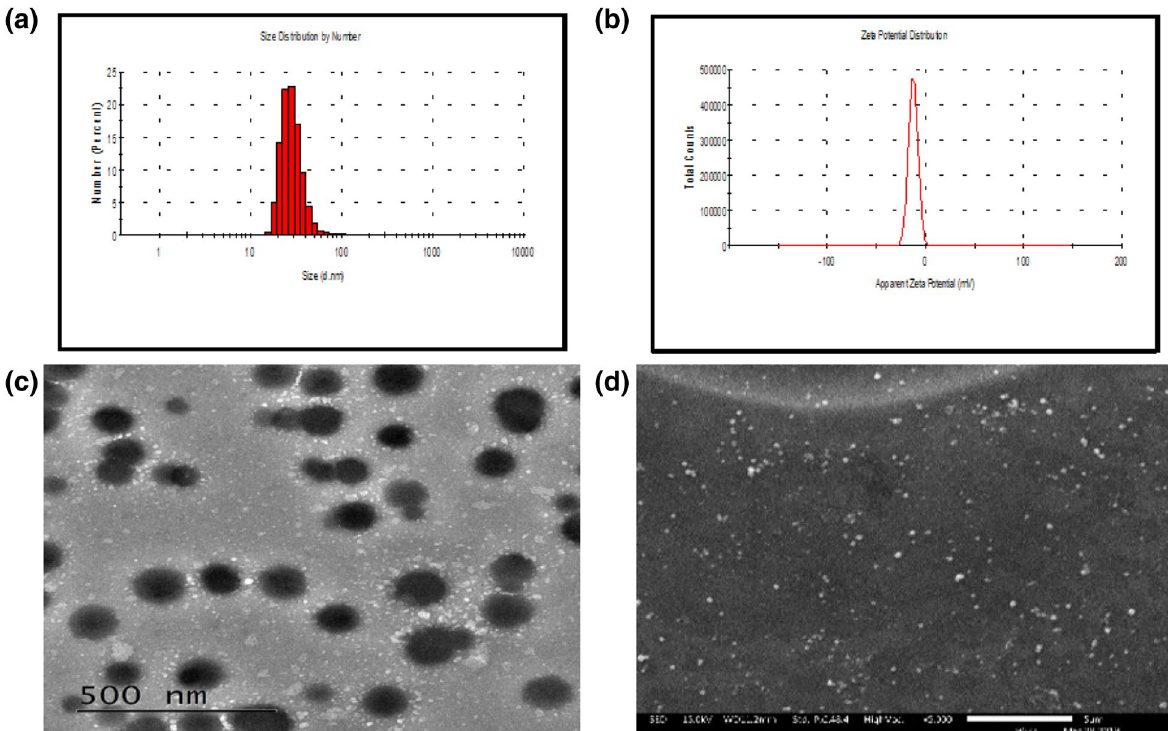
Figure 1. ( a ) Mean particle size (nm) of m-DDSLNs. ( b ) zeta potential (mV) of m-DDSLNs. ( c ) TEM image of m-DDSLNs. ( d ) SEM image of